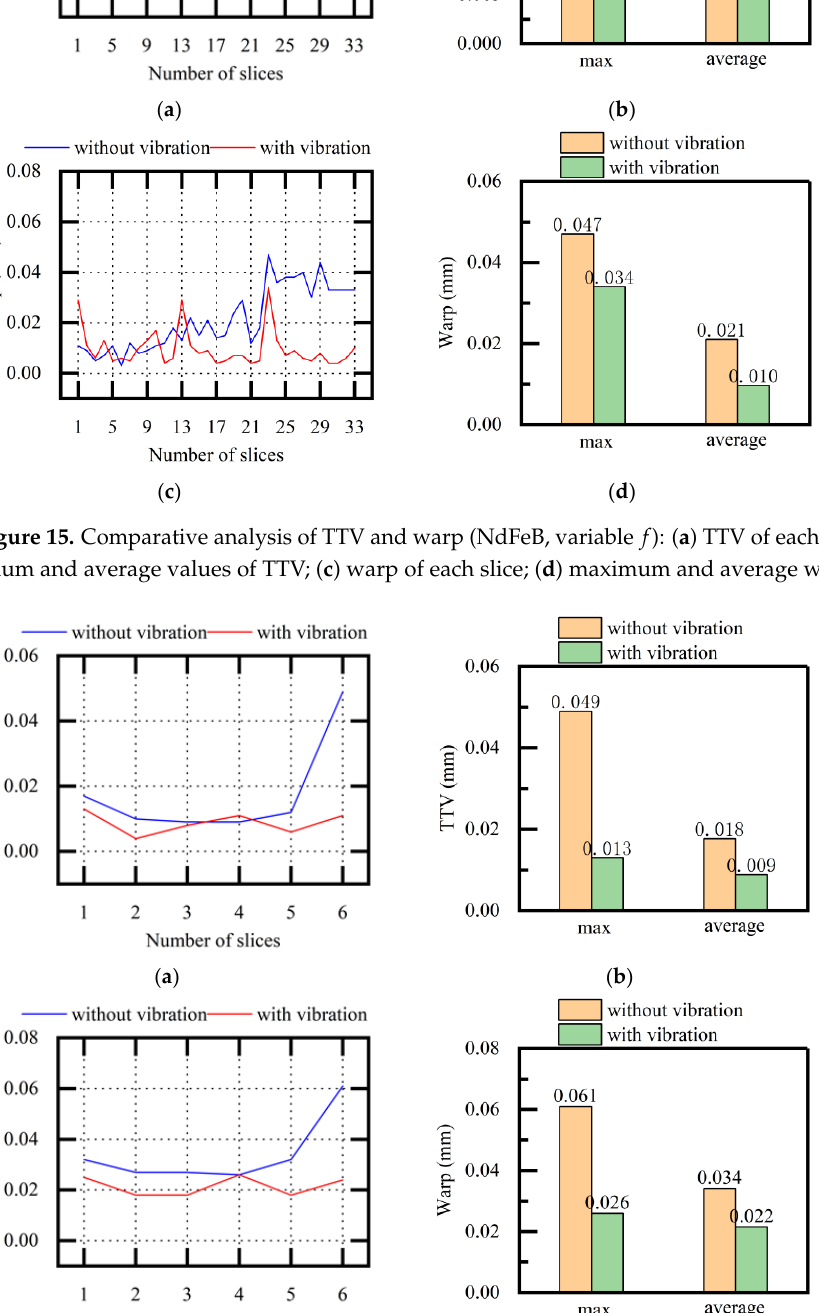
Figure 16. Comparative analysis of TTV and warp (SiC, variable f ): ( a ) TTV of each slice; ( b ) maximum and average TTV; ( c ) warp of each slice; ( d ) maximum and average warp. TTV and warp are important standards for measuring the quality of slices. In order to meet the needs of large-sized, high-precision, multi-slice processing, it is necessary to obtain good surface precision with good TTV and warp values. An unqualified TTV af- fects the chip pass rate and the production process, and the evaluation standards also put forward strict requirements for chip quality. Based on the above results, we concluded that the average values, maximum values, and standard deviations of TTV and warp were relatively reduced and that the sawing stability and surface quality were improved when using multi-wire sawing. Vibration-assisted technology could improve the pass rate of slices and optimize the production process. 4. Conclusions In this paper, a method of applying vibration assistance to ingot slicing was pre- sented that attempted to extend vibration assistance to the frequency range of 0 – 50 Hz. A sawing force prediction model for vibration-assisted wire sawing was established. The prediction model described the theoretical relationship between the process parameters and sawing forces. The relationships between sawing forces and process parameters, such as vibration frequency, wire speed, feed speed, and wire tension, were explored through